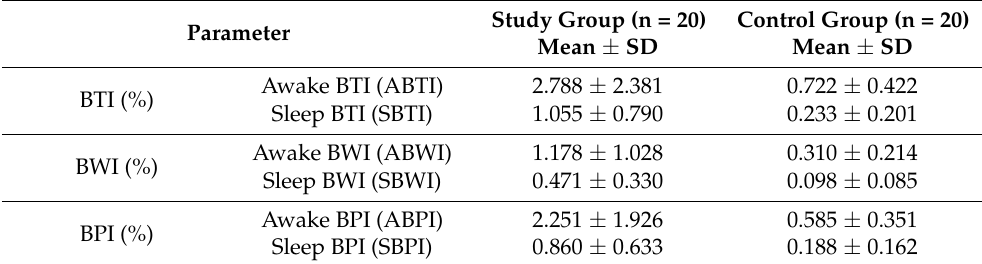
Table 2. The main parameters provided by the dia-BRUXO